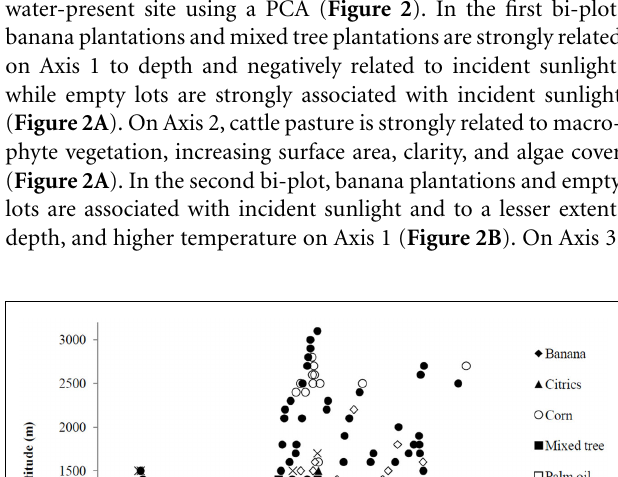
Frontiers in Physiology | Systems